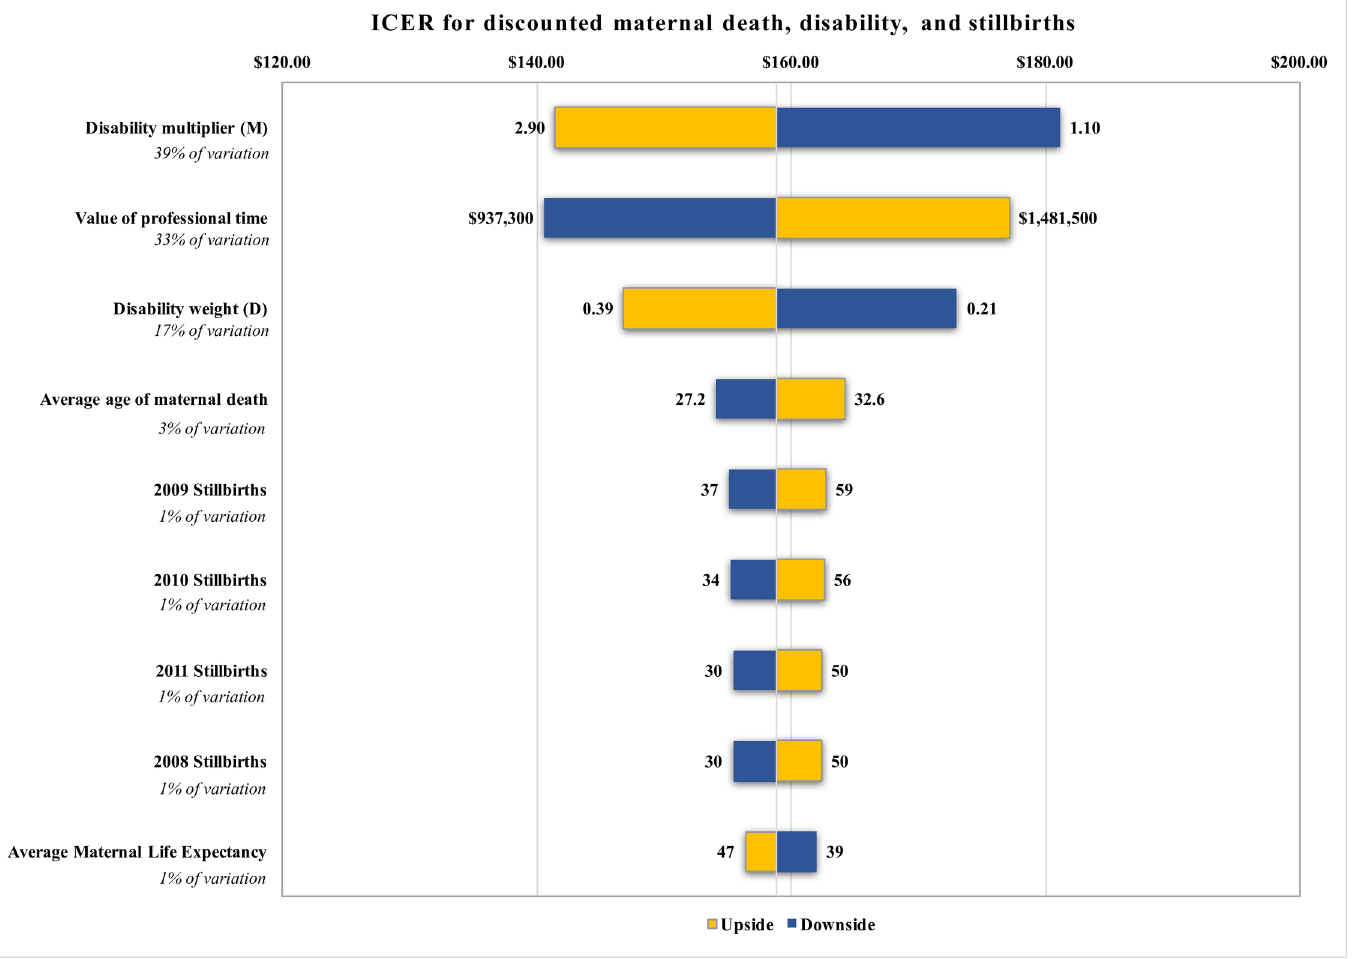
Fig 4. Tornado Chart of ICER for discounted calculations of maternal deaths, disability, and stillbirths showing all variables contributing (cid:21) 1% of the variation in the estimates. ICER, incremental cost-effectiveness ratio; Upside, this assumptionmakes the program more cost effective; downside, this assumption makes the program less cost